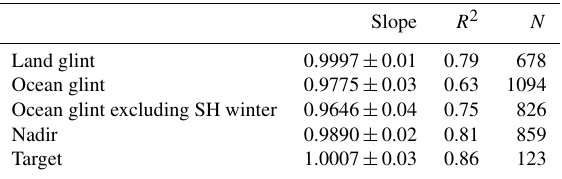
Table 5. Bias-corrected glint, nadir, and target relationships with TCCON. The slope and its uncertainty, R 2 , and number of daily median comparison points ( N ) are listed below for each OCO-2 viewing mode. The uncertainties on the slopes are the standard devi- ation of the slopes computed through bootstrapping. The values for ocean glint data with and without the Southern Hemisphere winter data are included on separate rows. Note that the slopes are com- puted after the global bias has been removed from the data and the residual footprint corrections have been applied. The glint and nadir data are filtered with warn level ≤ 11 and xco2 quality flag = 0; the target-mode data are filtered using the filters described in Table